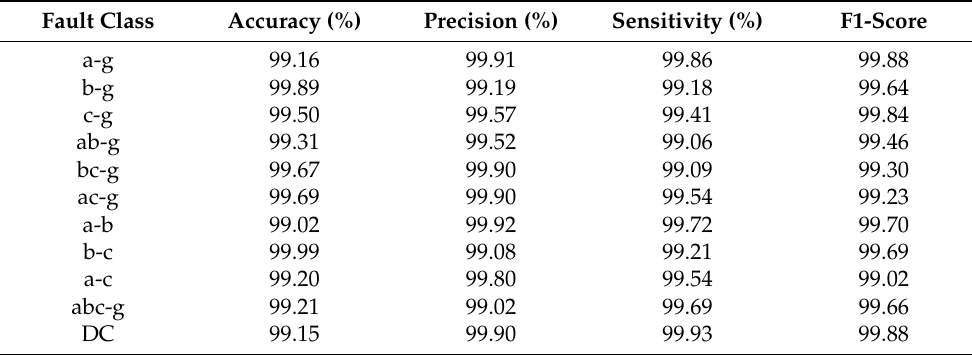
Table 2. Accuracy (%), Precision (%), sensitivity (%), and F1-Score